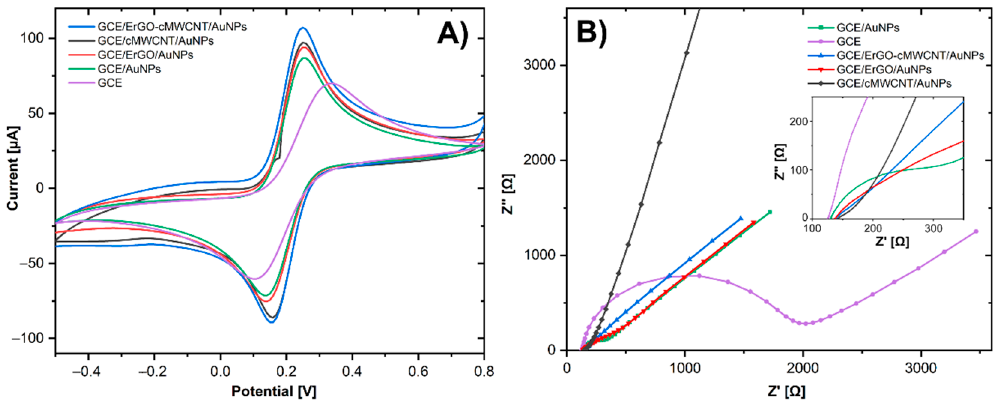
Figure 4. ( A ) CV in 5.0 mM [Fe(CN) 6 ] − 3/ − 4 containing PBS 0.01 M at 100 mV s − 1 , ( B ) EIS in 5.0 mM [Fe(CN) 6 ] − 3/ − 4 containing PBS 0.01 M.